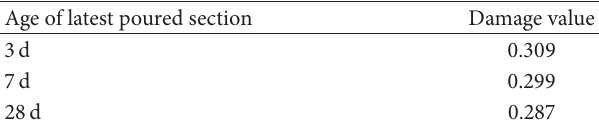
Table 7: Damage value on top of box girder under the velocity load of 2